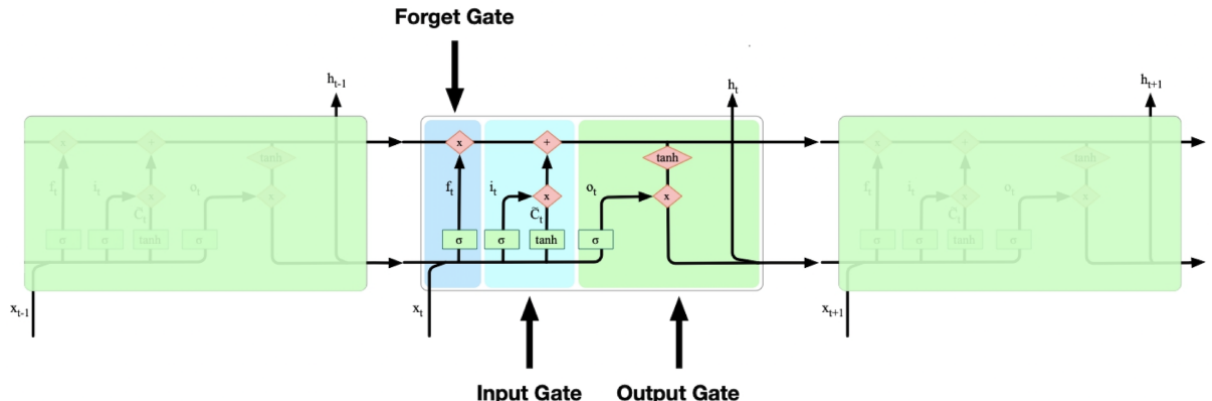
Figure 6. Diagram of the long short-term memory neural network with three functional